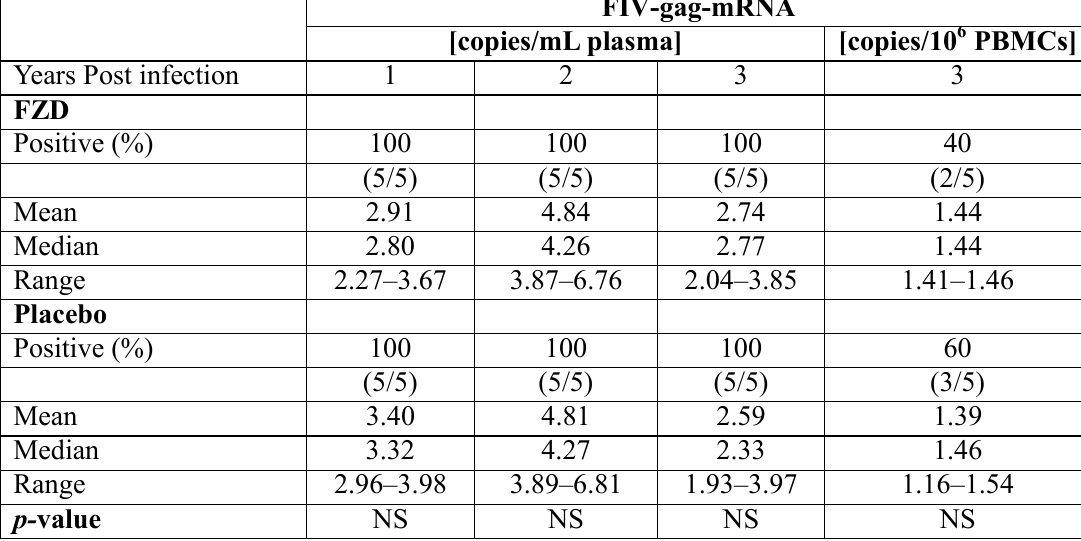
Table 1. Assessment of plasma- and cell-associated viremia in Fozivudine tidoxil (FZD) and placebo-treated cats during chronic Feline Immunodeficiency virus (FIV) infection. The percentage of positive cats by PCR analysis is shown in the first row for FZD- and placebo-treated groups and the corresponding number of cats out of each group is displayed on the second row. The mean, median, and range of the plasma viremia in number of virus copies/mL are listed for each treatment group at 1, 2, and 3 years PI. The mean, median and range of the cell-associated viremia in copies/10 6 Peripheral blood mononuclear cells (PBMCs) are listed for each treatment group at 3 years PI. Five cats were evaluated for each experimental group. ( p < 0.05, NS = not